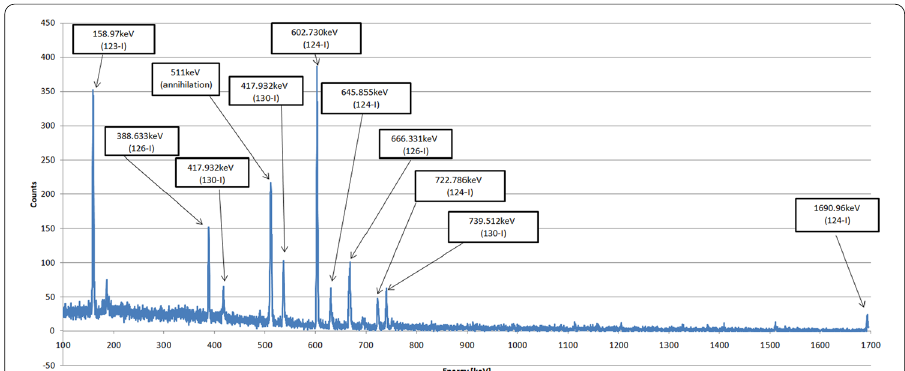
Fig. 8 HPGe spectrum.The peaks from the 124 I decay: at 603 keV, 645 keV, 722 keV and 1690 keV, and from the 123 I decay (158 keV), and also 126 I (388 keV and 666 keV) and 130 I (417 keV and 739 keV) as well as the annihilation process (511 keV) are indicated